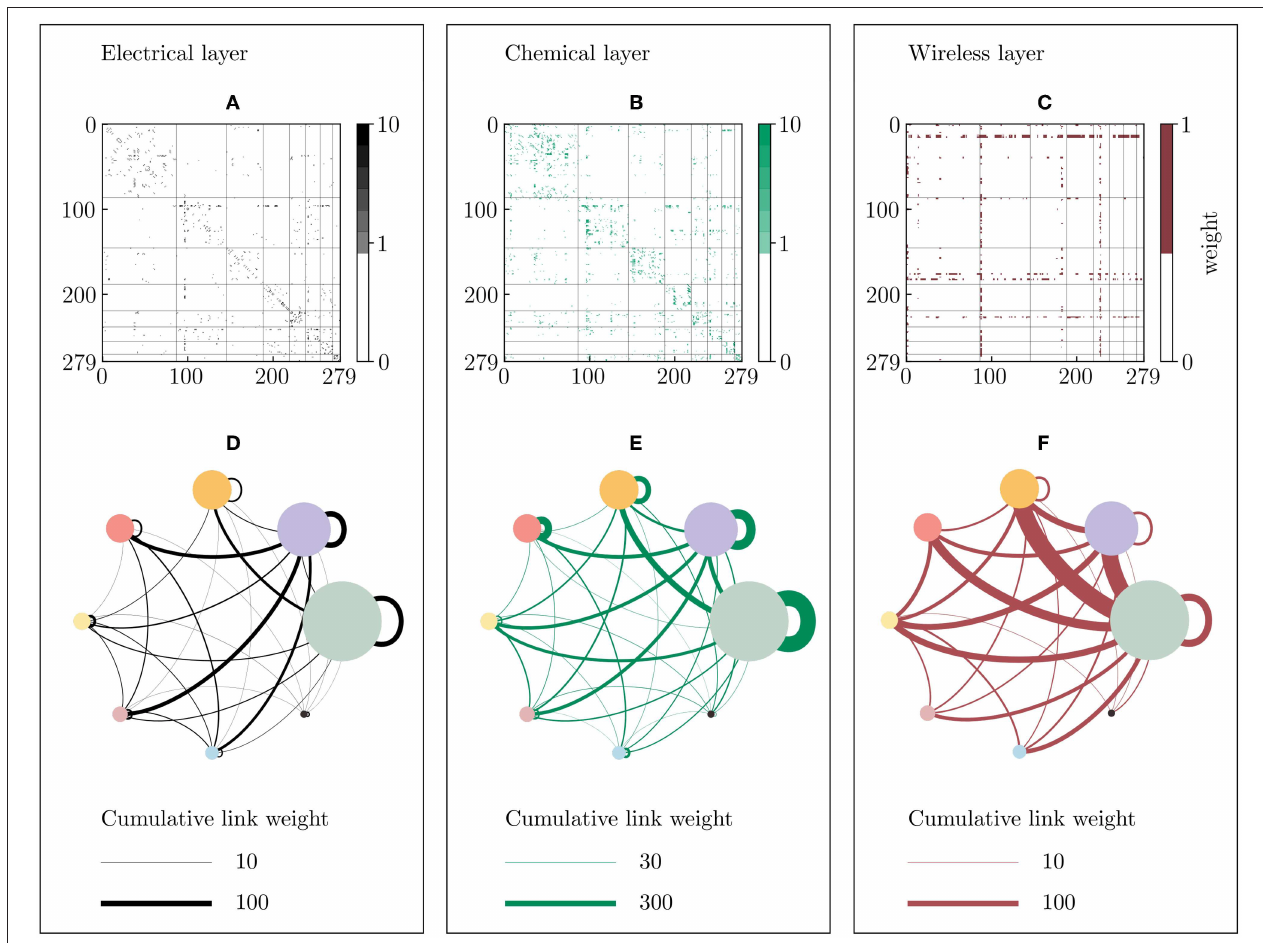
FIGURE 5 | Communities of the Multilayer-Louvain C. elegans network. The network is divided into 8 communities of different size using the Multilayer implementation of the Louvain algorithm (see Methods 5.4). (A–C) Weighted adjacency matrices of the electrical (black), chemical (green) and wireless (red) networks, where the axes represent the node indices. The vertical and horizontal lines divides the matrix in the counter-clockwise ordered communities, from left to right in the horizontal axis, and from up to down in the vertical axis, respectively. Note that the maximum depicted weight is set to 10 in both the electrical and chemical layers for visualization reasons, even though few higher weights exist. (D–F) Inter- and intra-community coupling of the three layers, where colored circles represent communities [1: gray (87 neurons), 2: violet (59 neurons), 3: orange (43 neurons), 4: red (31 neurons), 5: yellow (19 neurons), 6: pink (17 neurons), 7: blue (15 neurons), 8: black (8 neurons)], and lines represent the cumulative link weight between two or within one community